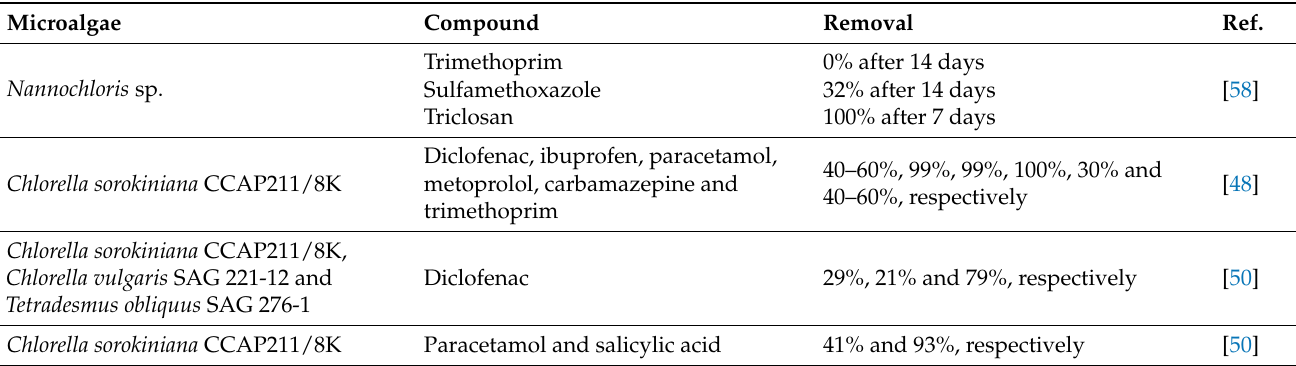
Table 2. Microalgae used for pharmaceuticals and personal care products removal from WWs. Microalgae Compound Removal